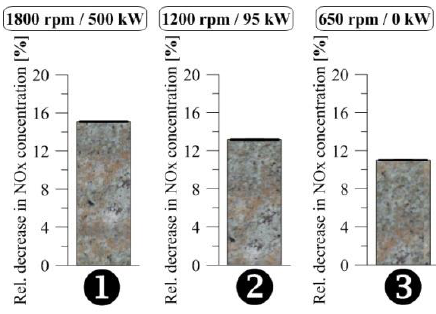
Fig. 19. Relative reduction of nitrogen oxides (NO x ) of the CAT C27 engine powered by the base fuel (BASE) and the base fuel with nitrON ® (TEST), for 3 points of test F ( 